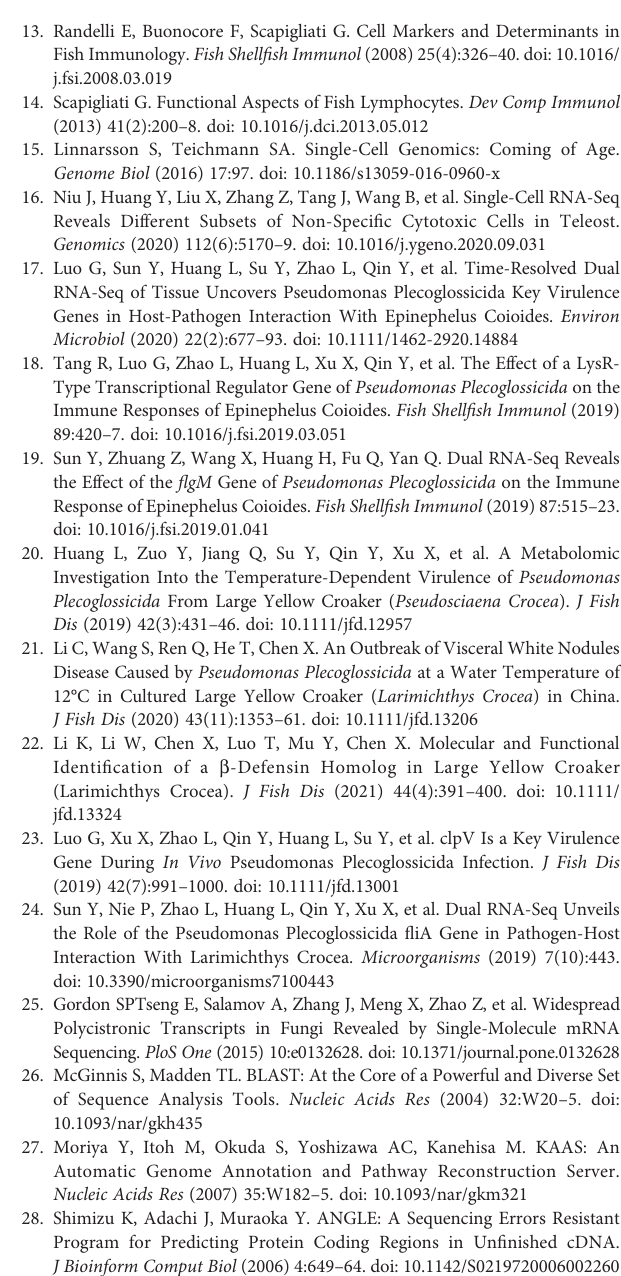
Supplementary Figure 2 | Mapping results of cell clustering based on the whole genome of E. lanceolatus back to the results of the full-length transcriptome. The tSNE nonlinear clustering was used to visualize the results. Supplementary Figure 3 | Visualization of the classi fi cation results of E. coioides spleen cell populations based on the full-length transcriptome (A) and E. lanceolatus whole genome (B) with UMAP. Supplementary Table 1 | Ordering Genes. Supplementary Table 2 | Detailed gene expression results of each cell population based on the E. lanceolatus